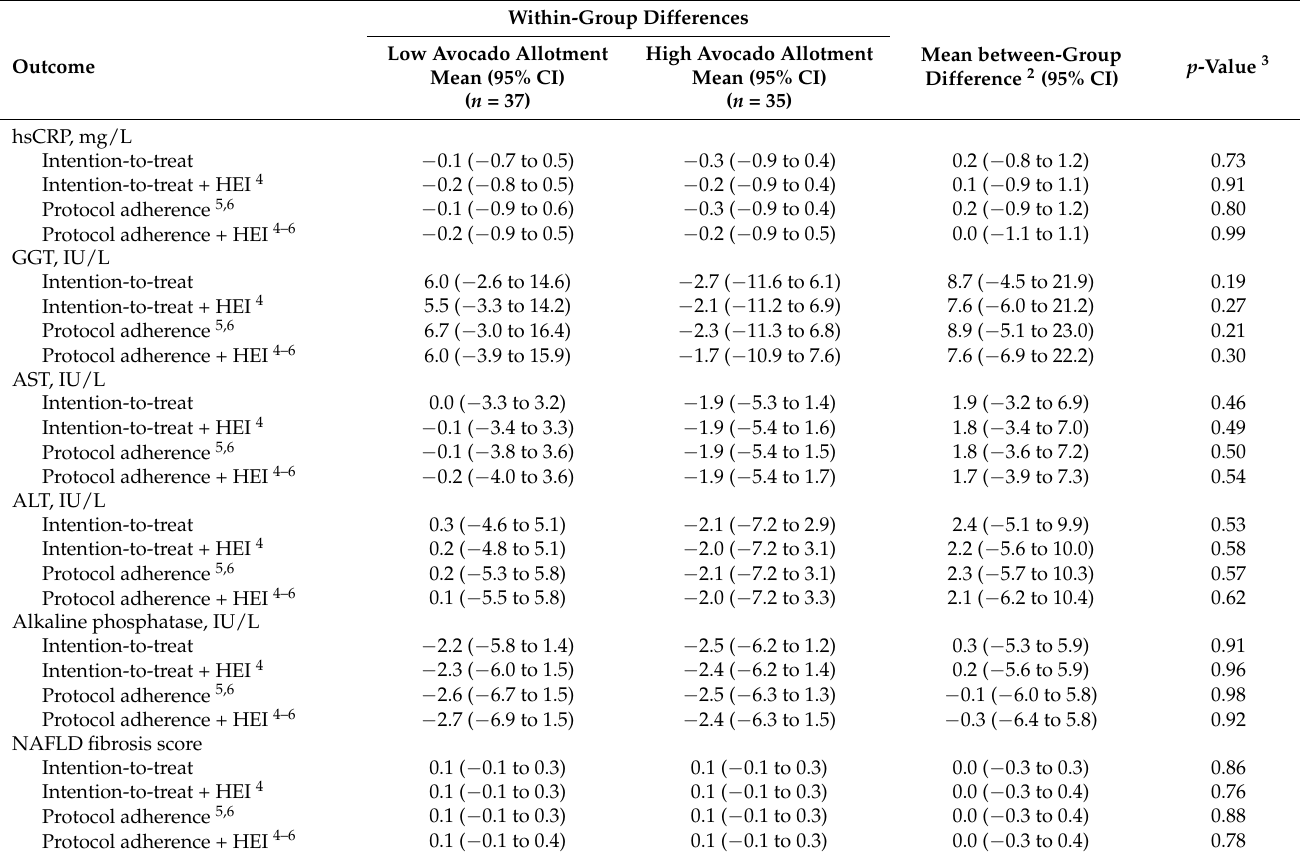
Table 4. Changes in hepatic function outcomes at 6 months after accounting for change in avocado intake 1 , per intention-to-treat and protocol adherence